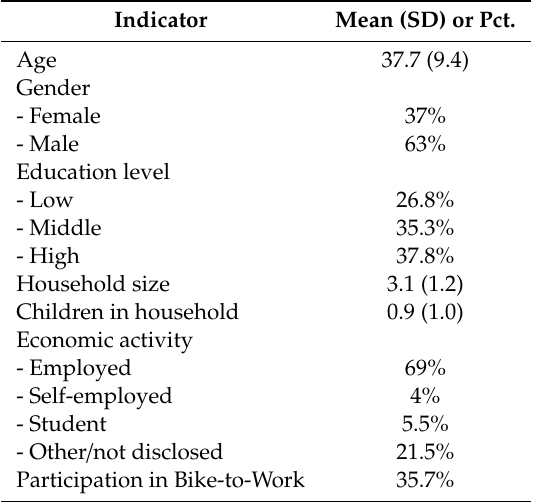
Table 2. Descriptive statistics of study participants ( n =